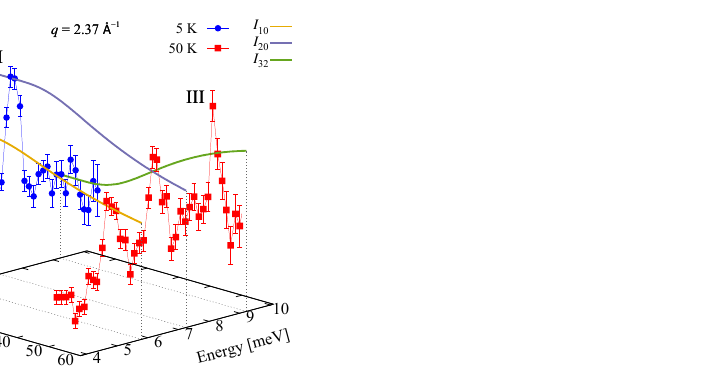
Figure 3. Experimental and calculated INS intensities of the single ion magnet Na 9 [Er(W 5 O 18 ) 2 ] as a function of neutrons’ energy transfer and temperature. Experimental data are taken from Reference [9]. The solid lines depict the calculated intensities I n (cid:48) n , where n (cid:48) and n denote the final and initial energy levels of the transitions shown in Figure 2a. The curves for I 10 and I 20 obtained from the spin–sigma and Heisenberg Hamiltonians overlap.